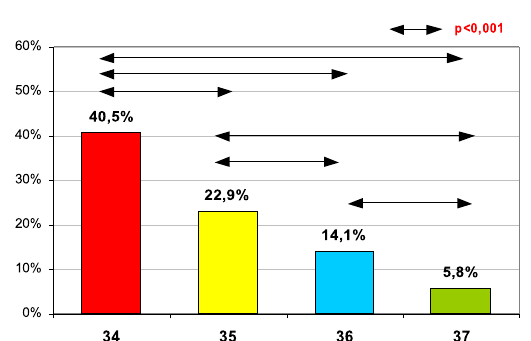
CS cesarean section VD vaginaly delivery Figure 3. Statistical deferences in respiratory distress syndrom in neonates who were born between 34 and 37 weeks